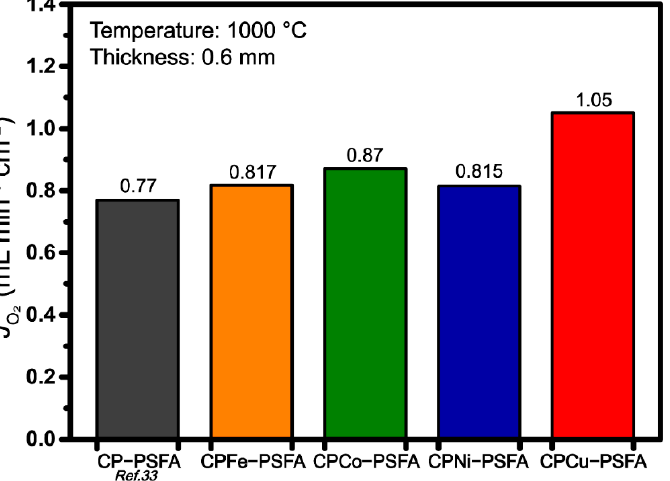
Figure 5. Comparison of oxygen permeation rates through the CPM-PSFA (M = Fe, Co, Ni, and Cu) composite membranes at 1000 °C. Condition: 150 mL min − 1 air as the feed gas, 49 mL min − 1 He as the sweep gas, and 1 mL min − 1 Ne as an internal standard gas. Membrane thickness: 0.6 mm.